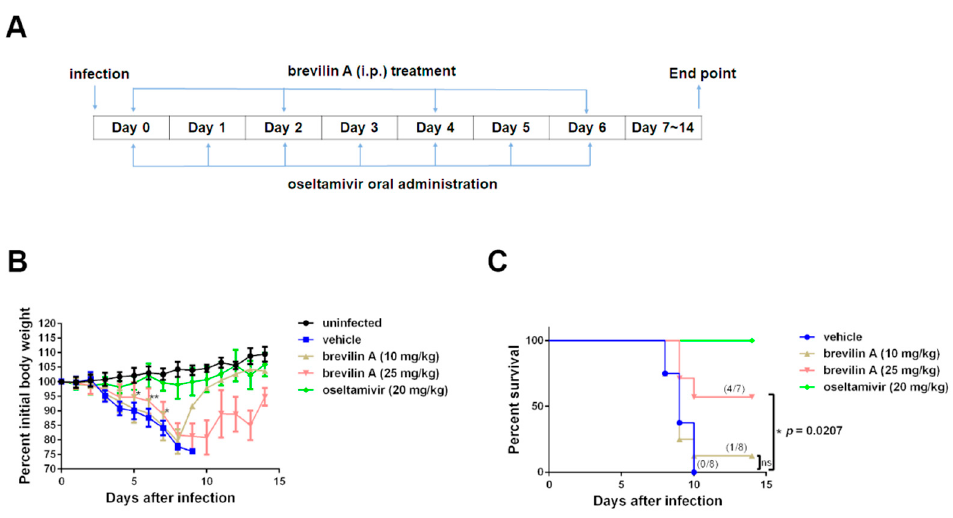
Figure 7. Brevilin A decreases the lethality observed in IAV-infected mice. ( A ) BALB / c mice were infected intranasally with three 50% lethal doses (LD 50 ) of PR8 virus. Brevilin A (25 mg / kg or 10 mg / kg) was intraperitoneally (i.p.) administered to mice 1 h after virus infection, and then once every other day for 6 days beginning on the day of infection ( n = 8). Oseltamivir phosphate (20 mg / kg) used as a positive control was administered by oral gavage every day ( n = 7). Vehicle (10% Lipovenos containing 0.2% DMSO, 10% PEG300 and 2.5% glycerol, n = 8) was used as a negative control. ( B ) The body weight of mice from each group was monitored daily from day 0 to day 14. The data represent means ± SD. ( C ) The survival rates of the mice were calculated. Animals falling below the threshold of 75% of their initial body weight were humanely euthanized. The p -value is shown (Log-rank (Mantel–Cox) test).